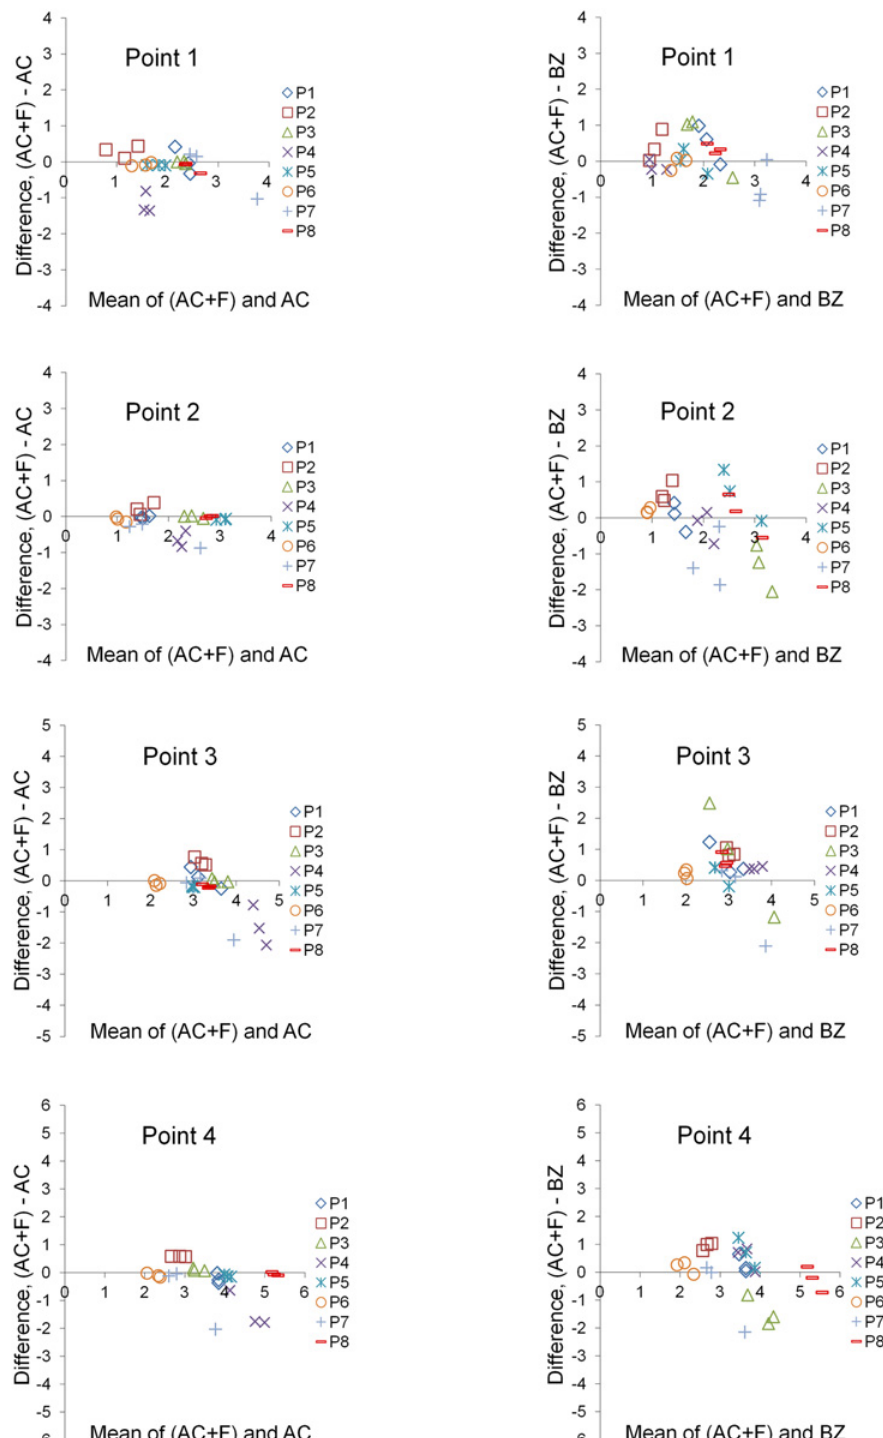
Fig 5. Differences of the AC and BZ superimposition techniques from the gold standard technique. Bland-Altman plots of differences of the anterior cranial base (AC) or both zygomatic arches (BZ) superimposition techniques from the gold standard superimposition technique (anterior cranial base + foramen magnum: AC+F). These consider the measured structural changes induced by treatment at four specific points, measured by each operator, for all eight patients (P). The axes length represents the true range of observed values of structural changes.